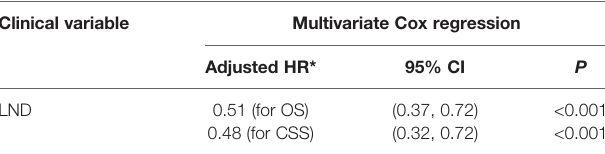
TABLE 5 | Multivariate Cox regression analysis for LND in the T3T4 subgroup penile cancer patients. Clinical